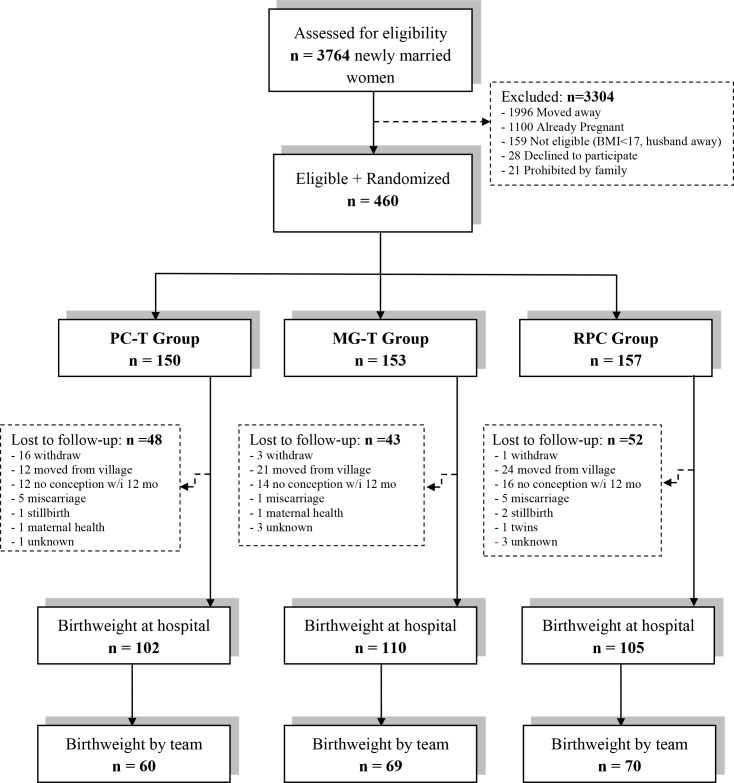
Flow diagram of participant progress throughout the VINAVAC study.PC-T, food supplement from pre-pregnancy to term; MG-T, food supplement from mid-pregnancy to term; RPC, routine perinatal care.